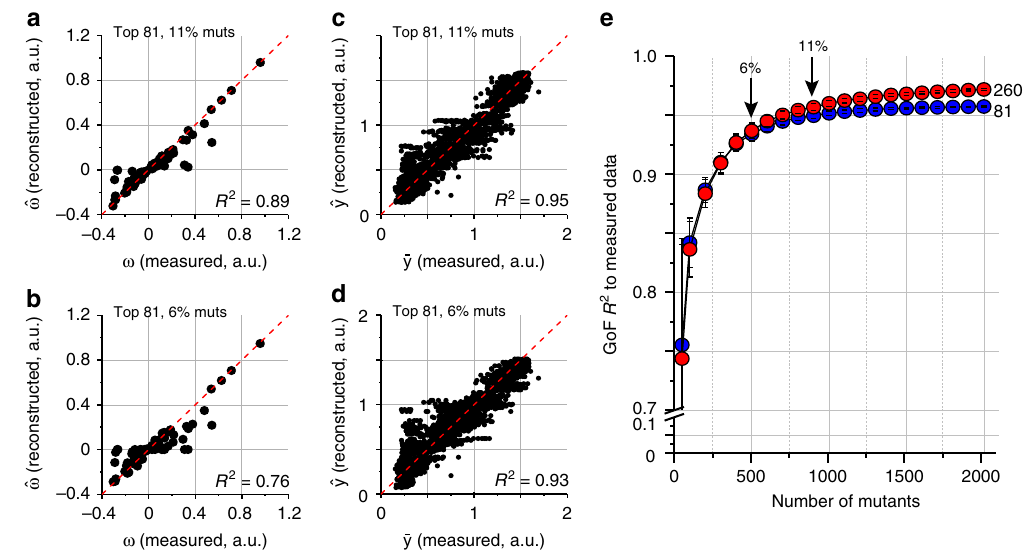
Fig. 4 Practical strategies for learning the epistatic structure: experiment. a , b Estimation of the top epistatic terms (including a broad range of high-order terms) from random samplings of phenotypes for 6 – 11% of variants, using the method of compressive sensing (CS). c , d Reconstruction of all phenotypes from the estimated epistatic terms in panels ( a – b ). The data show excellent approximation of relevant high-order epistasis and prediction of phenotypes from sparse sampling of data. e Goodness of phenotype prediction for all 8192 variants as a function of CS-based estimation of epistasis (top 81 or 260 terms) from many trials of sampling the indicated number of variants